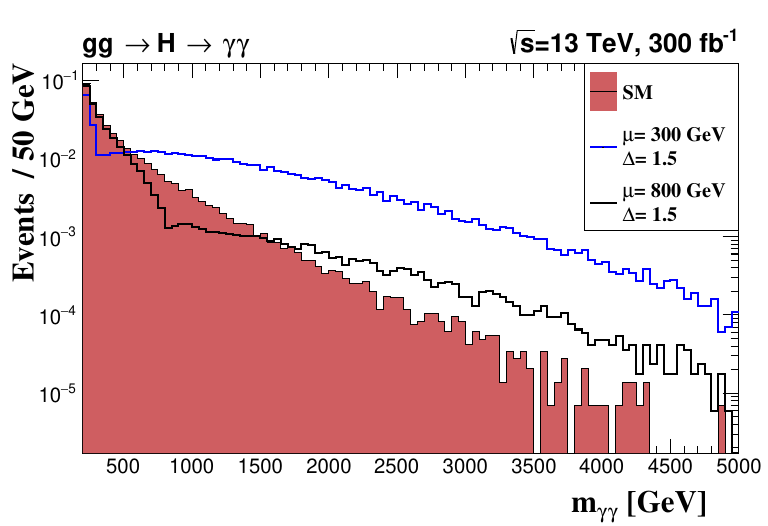
Figure 15. gg ! (cid:13)(cid:13) at 13 TeV center of the mass energy with 300 fb (cid:0) 1 integrated luminosity.